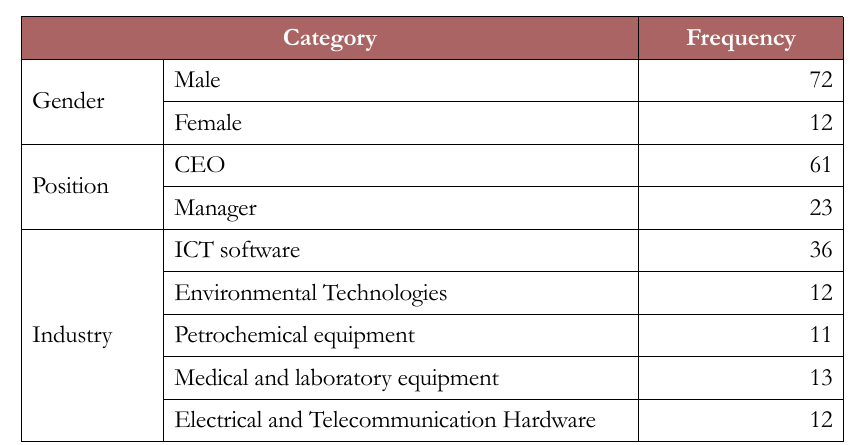
Table 9. Demographic information of